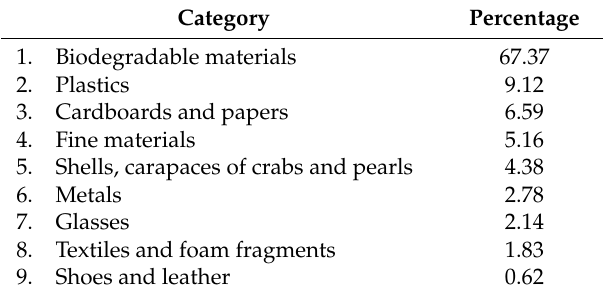
Table 2. Market waste characterisation (adapted from Tchakpa et al. (2012)